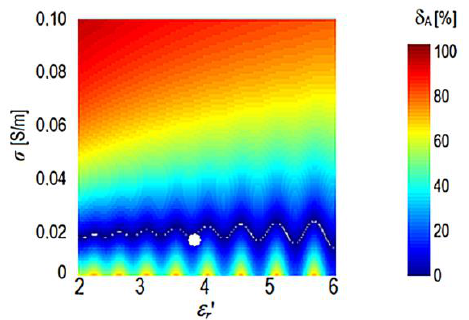
Figure 16. An example of the variability of the relative error of approximated ε r ’ and σ for the 2w_B30 model ( f = 5 GHz) with the initial assumption of σ FDTD = 0.04 S/m.